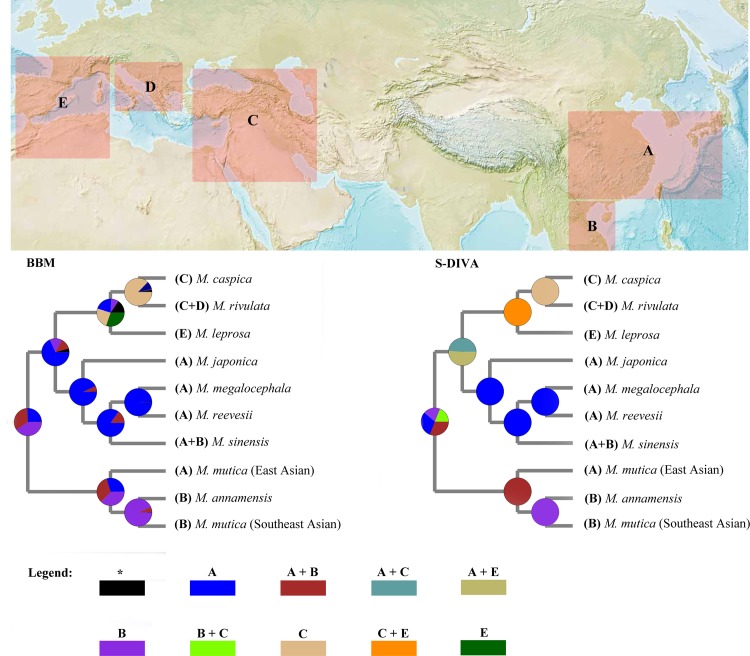
Results for ancestral area reconstruction inferred from BBM and S-DIVA based on mt heavy chain 12 protein-coding genes.The map is from the Central Intelligence Agency (CIA: https://www.cia.gov/library/publications/the-world-factbook/index.html). Potential original areas are coded as A: East Asia, B: Southeast Asia and Western Palearctic region (C: West Asia + D: West Europe + E: South Europe and North Africa), shown by different colours in the area pie chart.